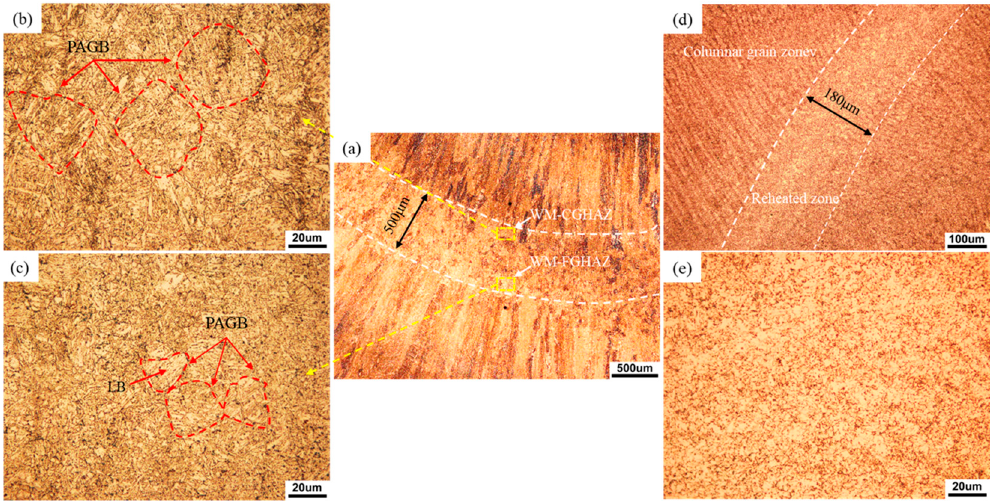
Figure 4. Optical microstructures of the reheated zone of weld metal: ( a–c ) SAW; ( d,e ) TIG.